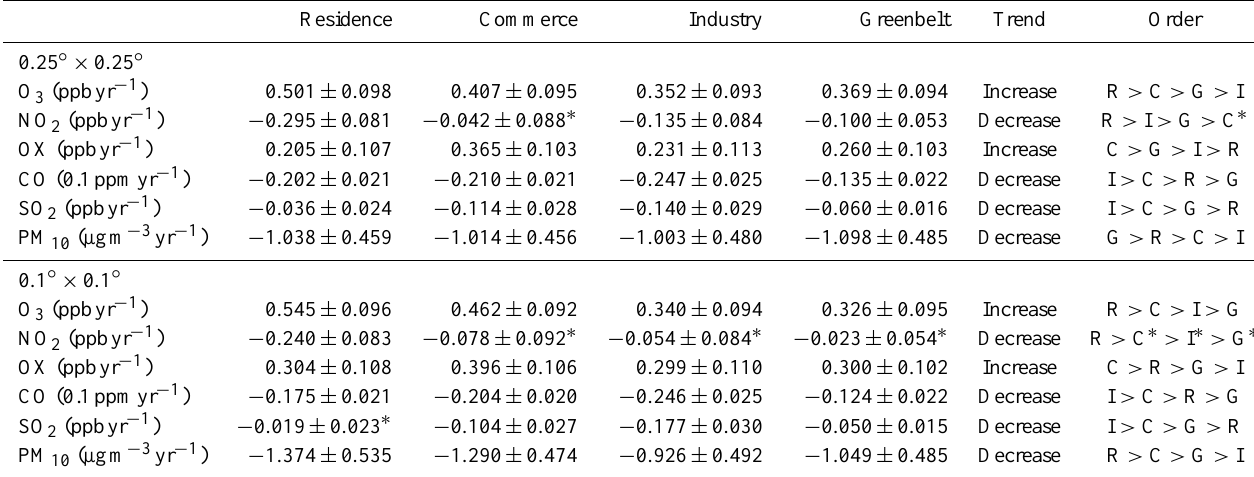
Table 9. Trends of surface air pollutants (O 3 , NO 2 , OX, CO, SO 2 and PM 10 ) over South Korea during 2002–2013, based on the three types of analyses (0 . 1 ◦ × 0 . 1 ◦ grid and 0 . 25 ◦ × 0 . 25 ◦ grid) over the four land-use types of the MEK of residence (R), commerce (C), industry (I), and greenbelt (G). The magnitude order for the trends of each of the pollutants over the types has been shown in the figures. The ± trend values indicate the 95% confidence intervals. It should be noted that the trend values are statistically significant except for some of the NO 2 and SO 2 cases, marked by an asterisk ( ∗